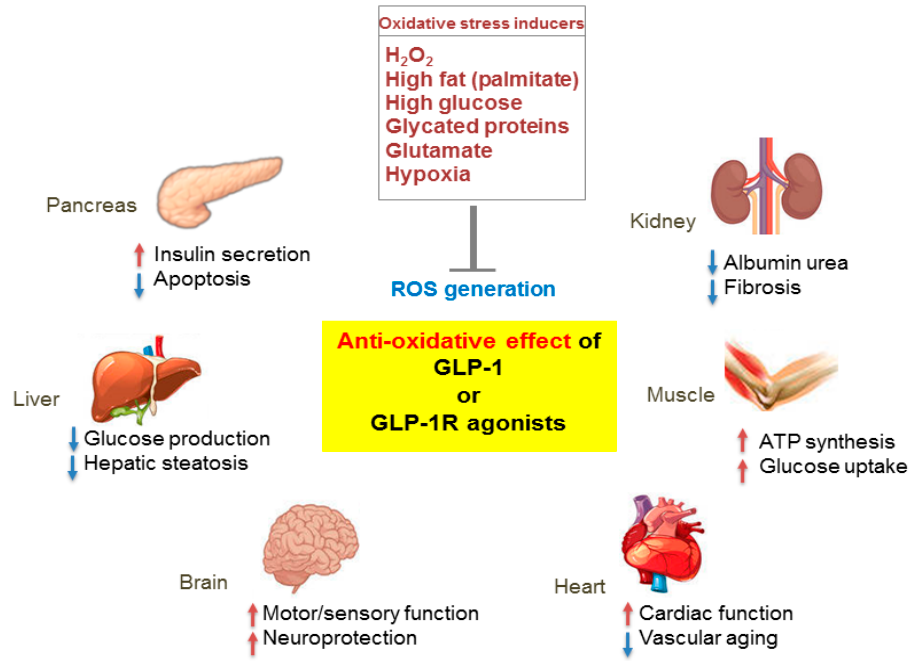
Figure 3. Pleiotropic effects of GLP-1 based therapies on antioxidant defense mechanisms in several organs. GLP-1 receptor (GLP-1R)-mediated signaling blocks reactive oxygen species (ROS) generation induced by various oxidative stressors and regulates the physiological function of various organs including the pancreas, liver, brain, heart, muscle, and kidney. Red arrows, increase; blue arrows, decrease.